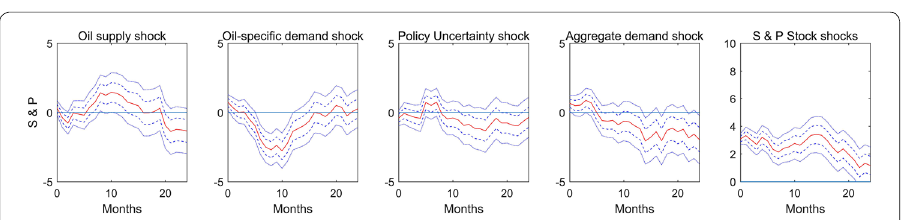
Fig. 4 Responses of S&P 500 stock returns to one and two standard deviation structural shocks: 2001:01– 2018:12. Notes: The figure shows the impulse response functions to one and two standard deviation structural shock, the order of SVAR model is oil supply shocks, aggregated demand shocks, oil specific demand shocks, economic policy uncertainty index and the real stock returns of the S&P 500 stock index described in the text. Point estimates are reported with one- and two-standard error bands constructed using a recursive-design wild